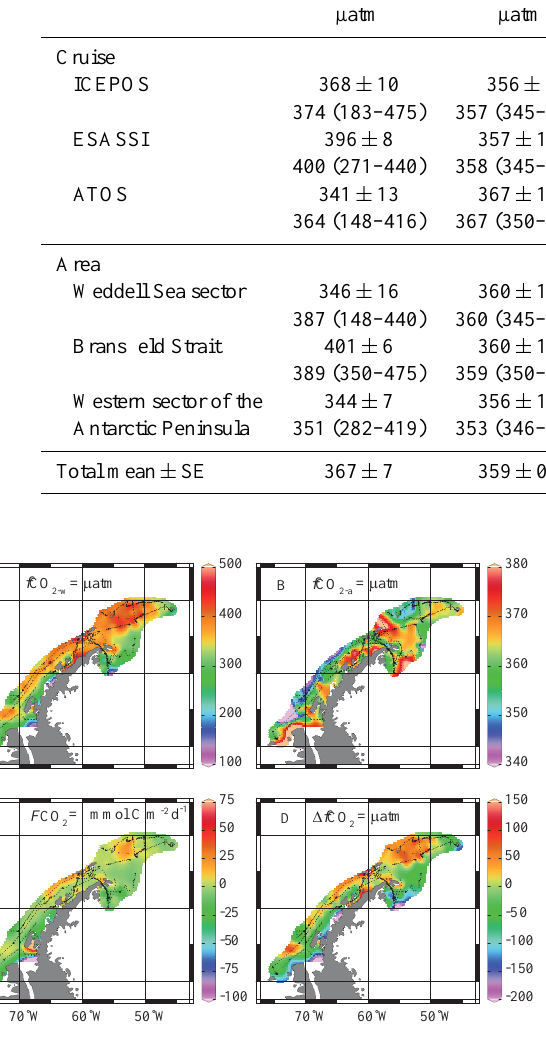
Figure 3. The distribution of shipboard continuous measurements (all three cruises combined) of f CO 2 − w (µatm, A ), f CO 2 − a (µatm, B ), F CO (mmolCm − 2 d − 1 , C ) and 1f CO 2 (µatm, D 2